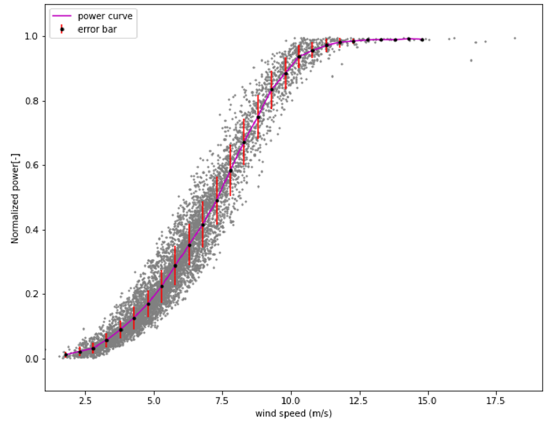
Figure 11. Power curve based on database after cleaning.